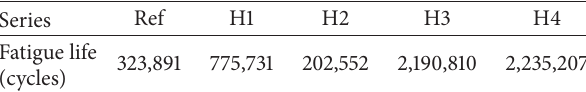
Table 3: Fatigue lives of four tested concrete